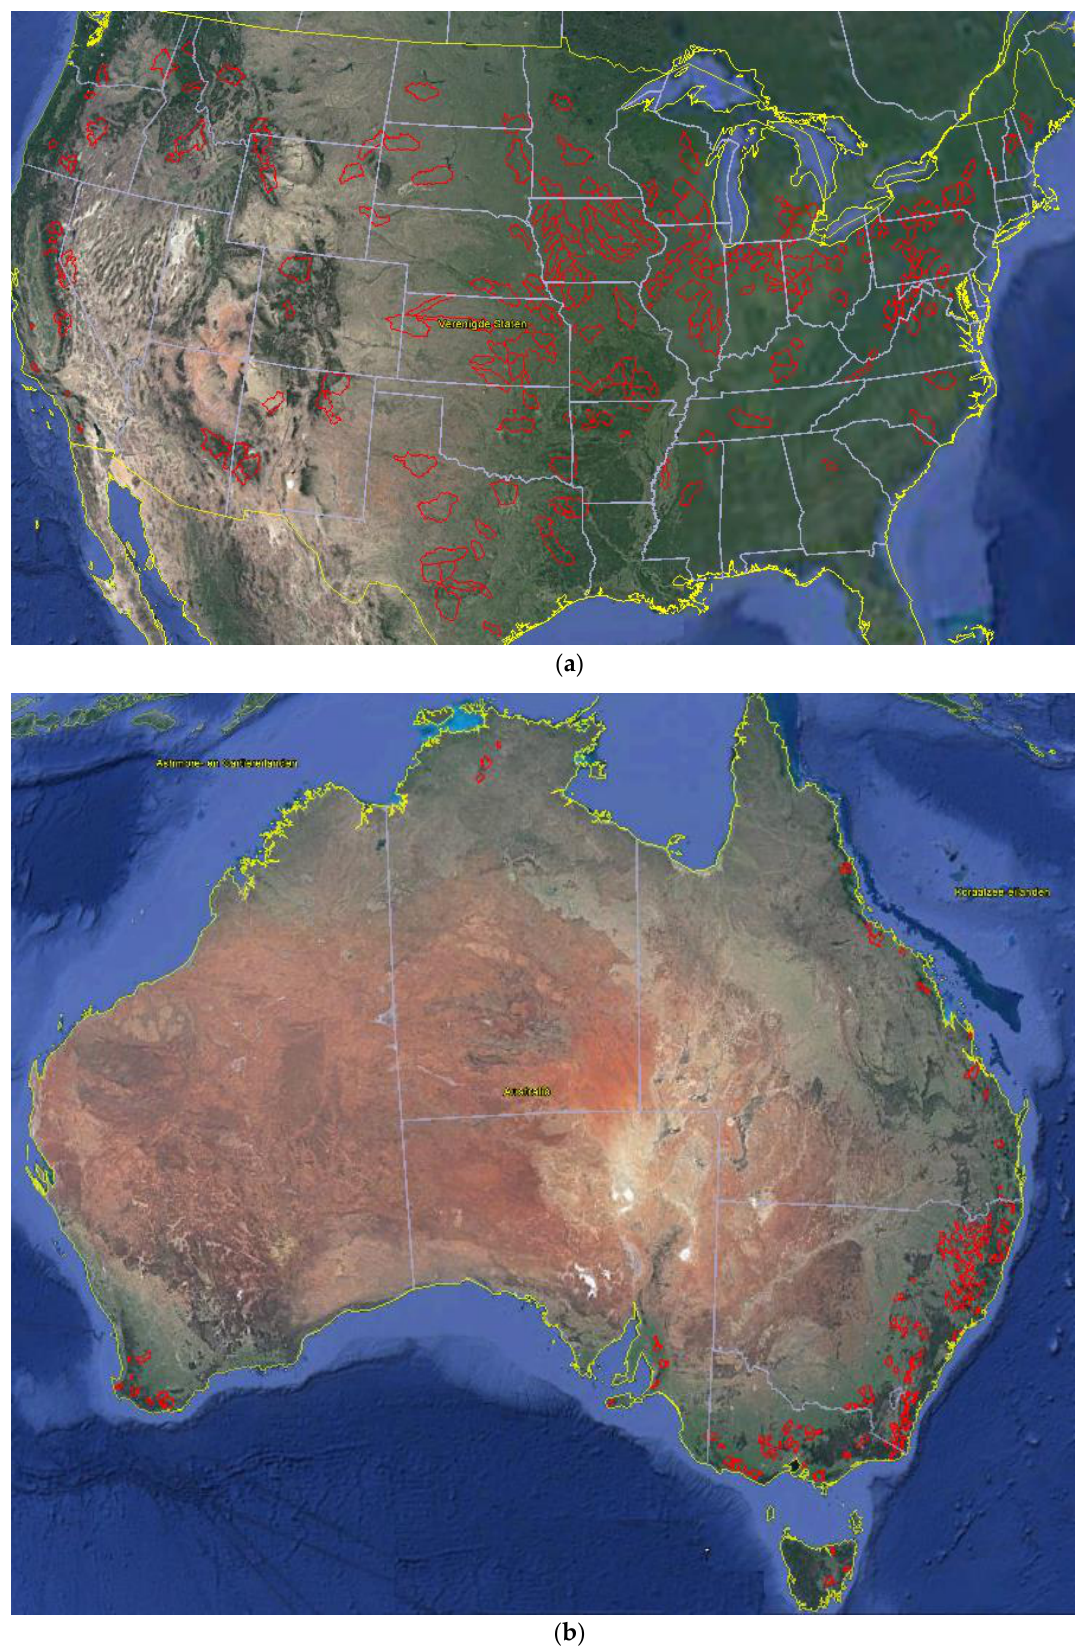
Figure 1. Maps of ( a ) the United States and ( b ) Australia with catchments included in this study, partly based on information from [20,21].